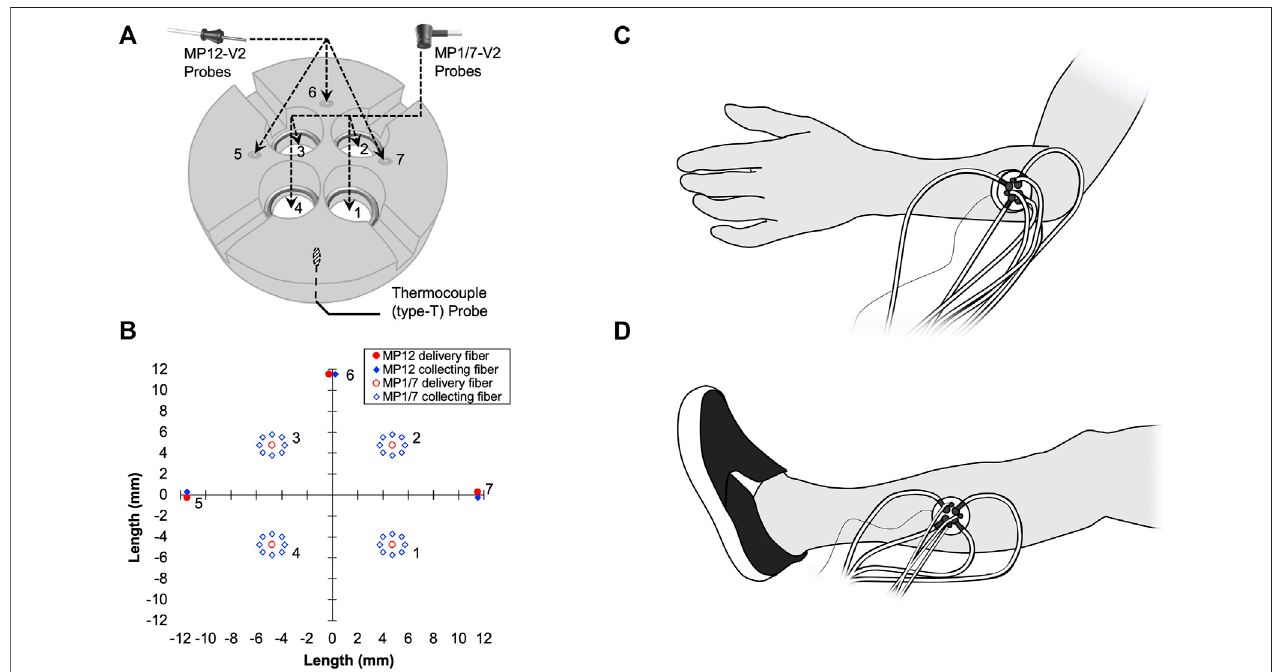
FIGURE 1 | A schematic representation of the custom-made laser Doppler fl owmetry (LDF) probe holder (A) is shown. Four MP1/7-V2 right angle probes were placedintotaperedholes(1, 2,3,and4).ThreeMP12-V2bluntneedleenddeliveryprobeswereinsertedintothreesmallholes(5,6,and7).Athinthermocouple(typeT) used to measure skin temperature (Tsk) was placed between the bottom of the probe holder and the surface of the skin. LDF probe-to-probe separation distances in millimeters are plotted (B) . The location of the probe holder during the Arm Trial (C) and Leg Trial (D) are shown.